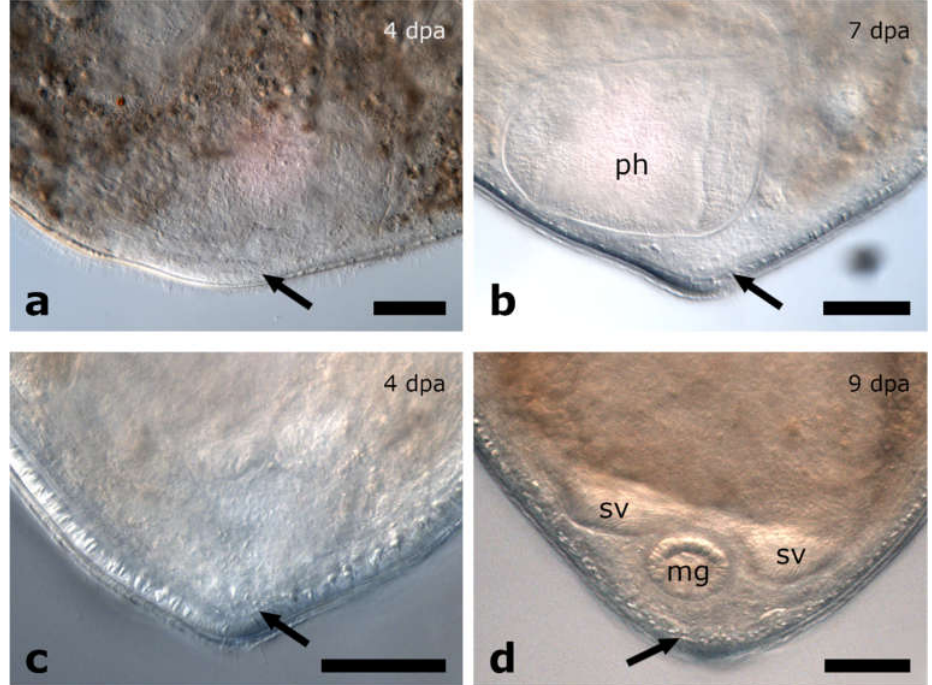
Figure 5. Blastema-like tissue in posterior regenerates of Cylindrostoma monotrochum . After being amputated through the middle of the pharynx ( a , b ) or posterior to the pharynx ( c , d ), an unpigmented, blastema-like structure was formed at the wound site ( a , c ). The structure continued growing and finally build a new pointy tail tip ( b , d ). Arrows are pointing at the blastemal-like tissue. Abbreviations: mg, male genital organ; ph, pharynx; sv, seminal vesicle. Scale bar is 50 µm.